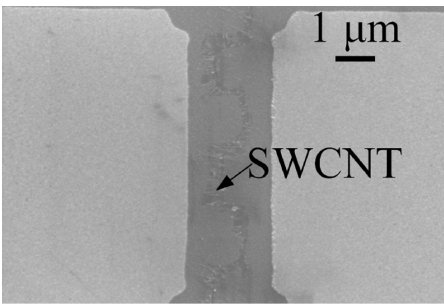
Figure 11. SEM image of SWCNT-graphene FET.